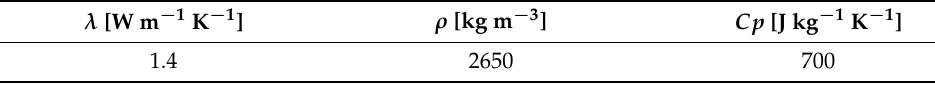
Figure 2. Schematic of Yang’s experiment tube [1]. Table 1. Physical properties of quartz at 20 ◦ C.